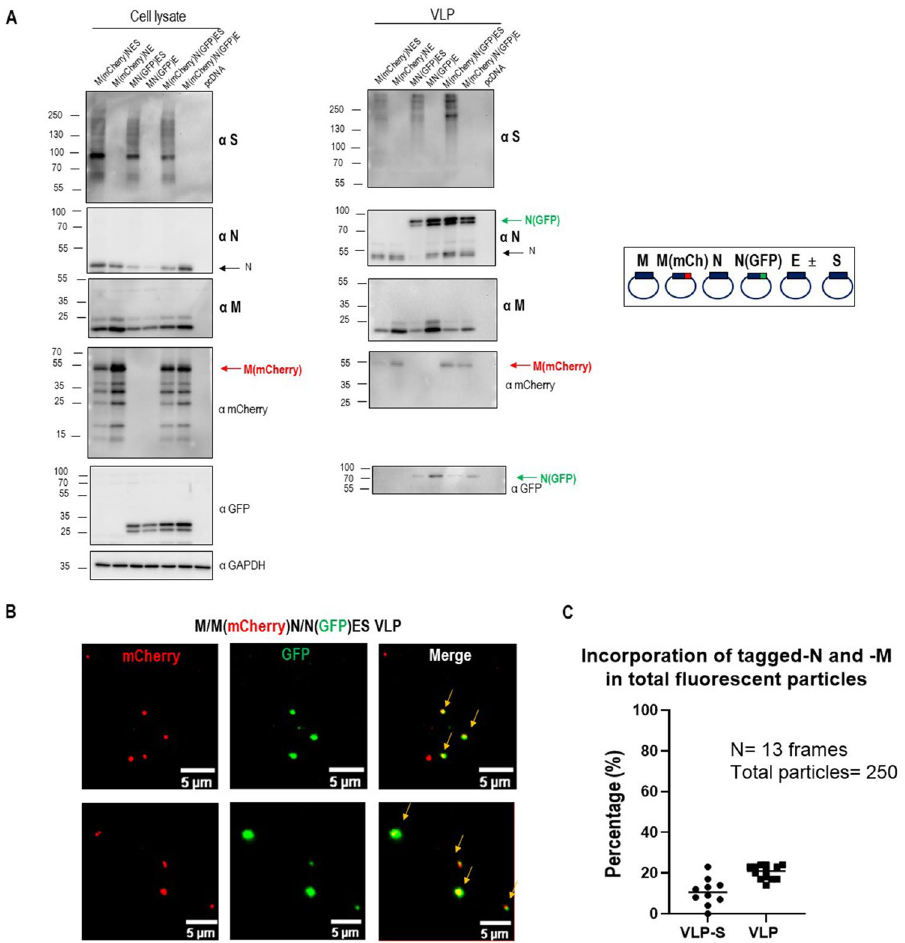
Figure 3. Description of dual-color fluorescent SARS-CoV-2 VLPs with tagged-M and -N incorporation. ( A ) Western blot of cell lysates and VLPs of HEK293T cells transfected with M, M(mCherry), N, N(GFP), E and S with the optimal ratio of M/M(mCherry)/N/N(GFP)/E ± S plasmids 2/2:9/3:2 ± 5. ( B ) Images of dual-color SARS-CoV-2M(mCherry)N(GFP)E ± S VLPs using TIRF Microscopy. Arrows show dual-color VLPs. The scale bar is 5 µm. ( C ) Quantitative colocalization of dual color GFP/mCherry VLPs using ComDet plugin in ImageJ. For each condition, 250–300 fluorescent particles were counted over 13 images (frames). One point in the graph represents the % of GFP/mCherry colocalization in one frame. N = 2, 250 particles